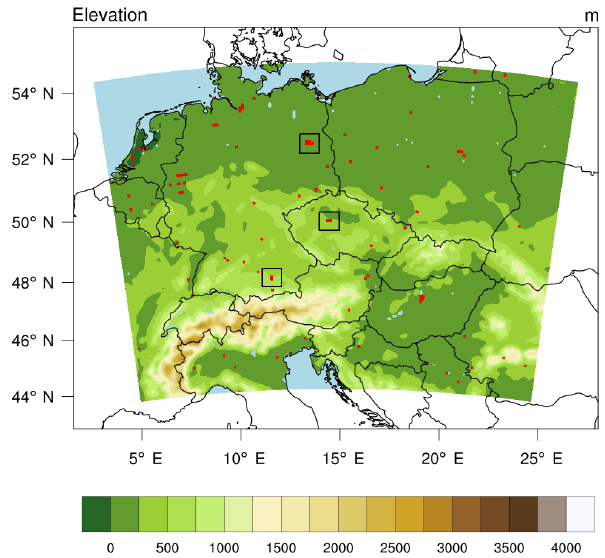
Figure 1. Position of the model domain with model topography in 10km resolution (m). Grid boxes with dominant urban land use are marked in red colour. From the bottom, the cities of Munich, Prague and Berlin are